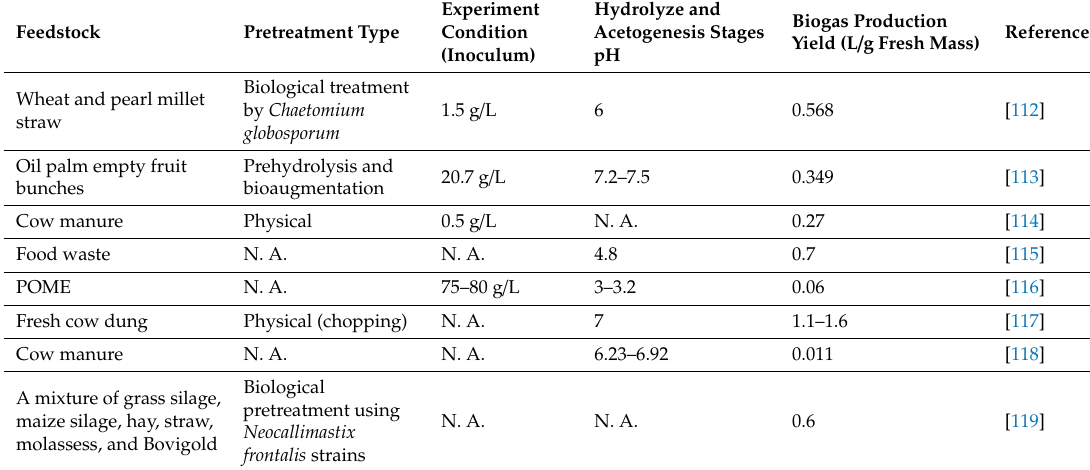
Table 6. Recent studies of di ff erent biogas production methods from di ff erent sources in Malaysia. Feedstock Pretreatment Type